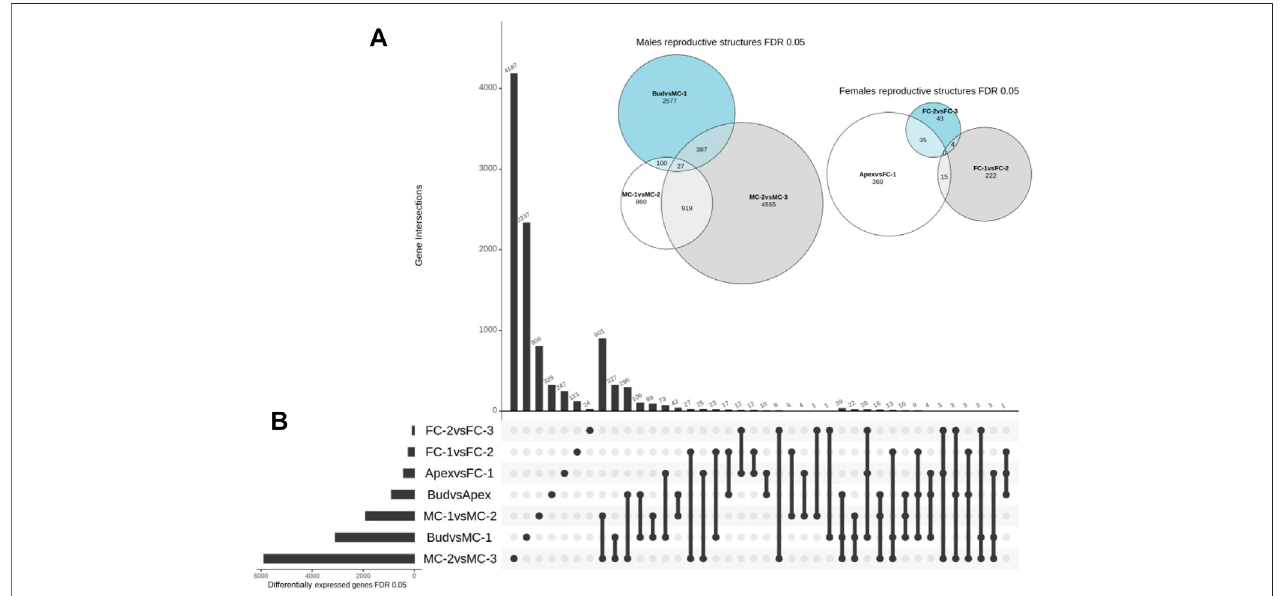
FIGURE3| Overview ofspatial and temporal differential gene expression. (A) Euler diagram showingthe number and overlap ofDEGs between thetimepoints for each gender. Size of the bubble refers to the total number of DEGs and outer numbers represent DEGs only in this comparison. (B) UpSet plot summarizes the DEG overlap betweenall sevensetcomparisons.The horizontal bars show thenumber ofdifferentially expressed genesidenti fi ed byeach comparison, while thevertical bars display the size of sets of genes identi fi ed by only one comparison and the intersection sets. Single dots and the corresponding horizontal bars represent the number of genes that are unique for that dataset and not shared between the other